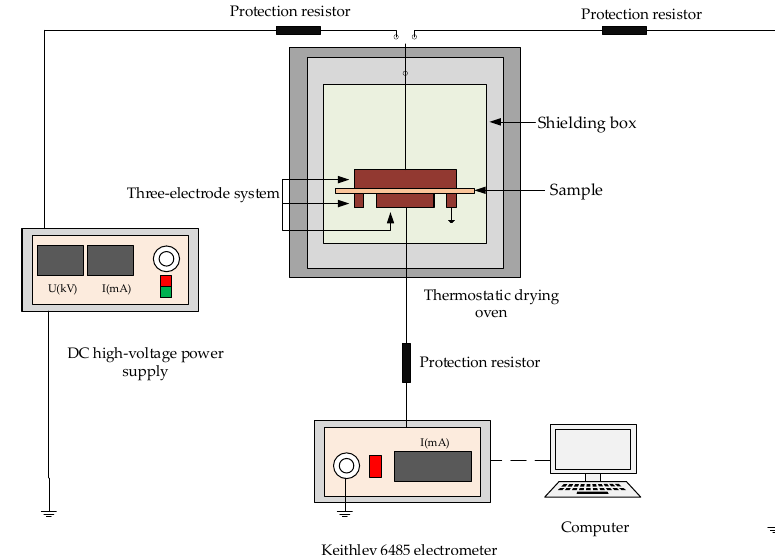
Figure 1. Charging and discharging current testing system.